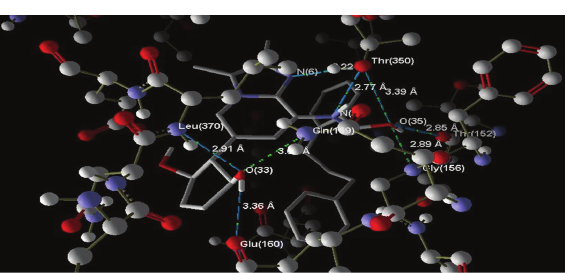
Figure 3: A model showing hydrogen-bond interactions of pre- dicted compound 2 (Table 2) with the enzyme H + /K + -ATPase. Compound 2 is one of the compounds that have the highest number of H-bonds.